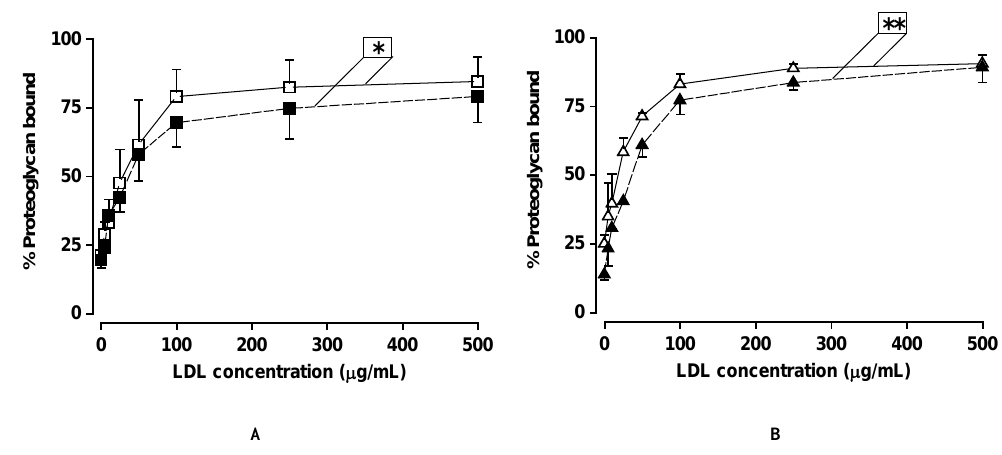
FIGURE 1. vSMCs treated with gemfibrozil in the presence of TGF- β 1 or PDGF synthesize proteoglycans that show reduced binding to LDL. vSMC proteoglycans were metabolically labeled with [ 35 S]-met/cys in the presence and absence of gemfibrozil (100 μ mol/l) with (A) TGF- β 1 (2 ng/ml) or (B) PDGF (50 ng/ml) with insulin (1 μ M ). Secreted proteoglycans from vSMCs were isolated and equal counts (1500 cpm) were mixed with increasing concentrations of LDL and separated by electrophoresis, on agarose gels. The percent of proteoglycans bound was plotted against the LDL concentration to generate binding curves. Open squares, TGF- β 1-treated cells; closed squares, vSMCs treated with gemfibrozil (100 μ mol/l) and TGF- β 1; open triangles, PDGF-treated cells; closed circles, gemfibrozil (100 μ mol/l) and PDGF/insulin. Each point (n = 2–4) represents the mean ± SEM from 1–2 experiments performed in duplicate and was